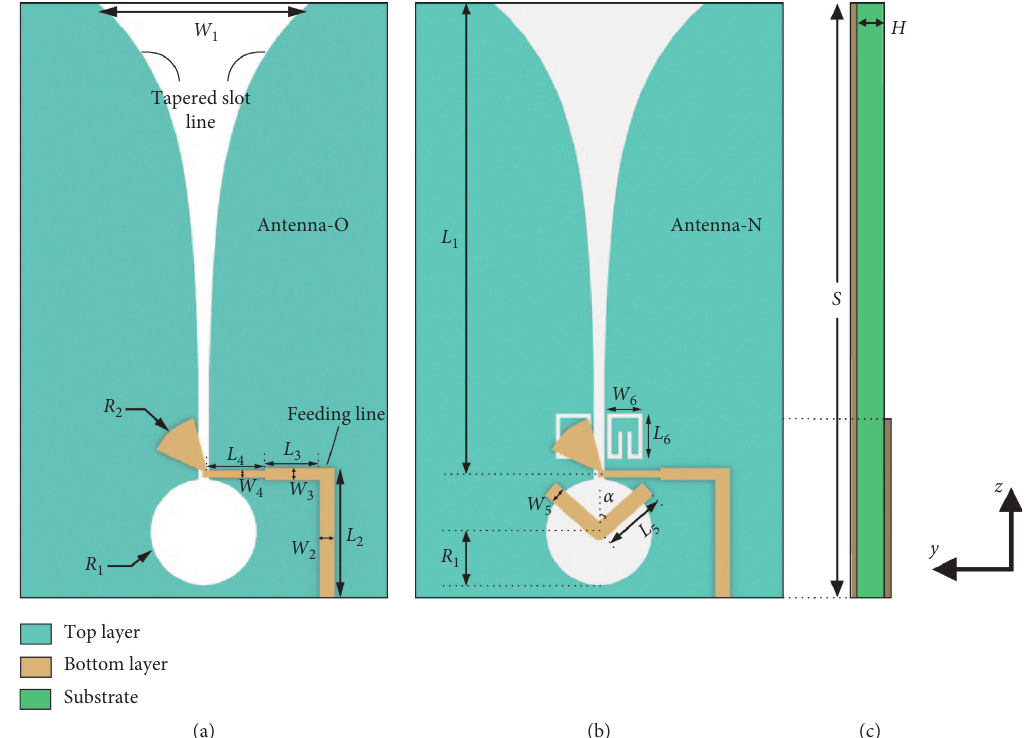
Figure 1: Geometry and configuration of the UWB antennas. (a) Original Vivaldi antenna. (b) Proposed Vivaldi antenna with a notched band. (c) Side view.